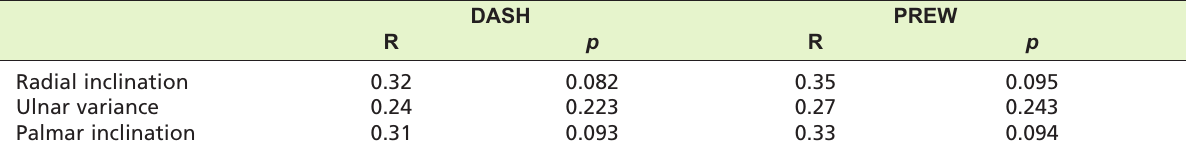
Correlation between radiological parameters and clinical scores at 12 months follow-up (Pearson Correlation Test) Table IV: